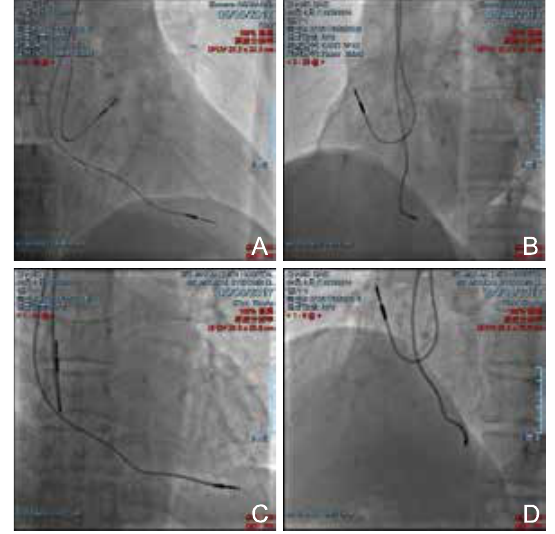
Figure 3 Fluoroscopy images taken after pacemaker implantation. Top images show the right ventricular pacemaker lead close to the boundary of the heart directly after the device was implanted (A and B). Bottom images show the right ventricular lead protruding from the heart border 2 days after device implantation (C and D). Arrows point to the tip of the right ventricular